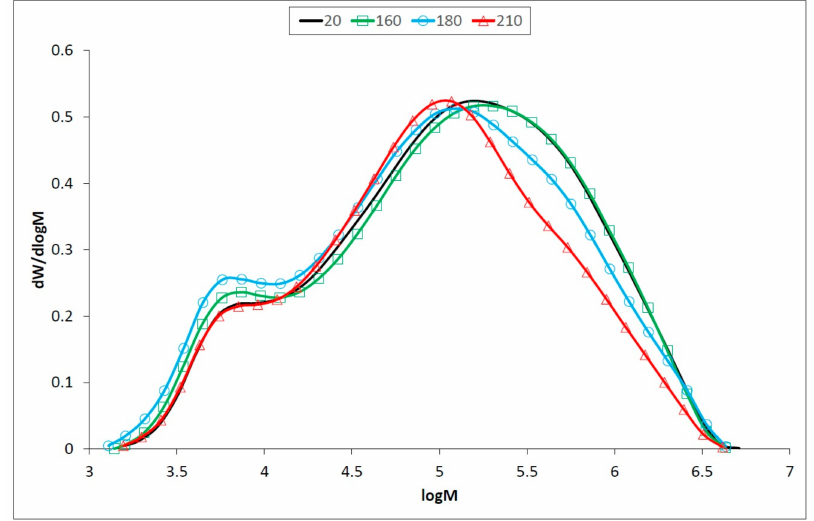
Figure 6. Molecular weight distribution of oak wood cellulose before and after thermal